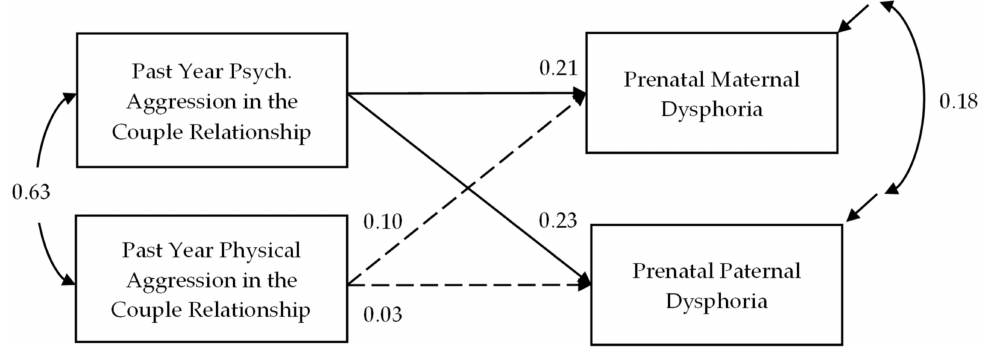
Figure 1. Psychological (Psych.) Aggression is Uniquely Associated with Negative Affectivity (Dysphoria Scale of the IDAS-II). Standardized estimates. Significant effects ( p < 0.05) are depicted with a solid line, and non-significant effects are depicted with a dashed line. This model was just identified. The week of pregnancy, age of each partner, ethnicity of each partner, annual joint income, and relationship duration were included as covariates in the model but are omitted from the figure for ease of